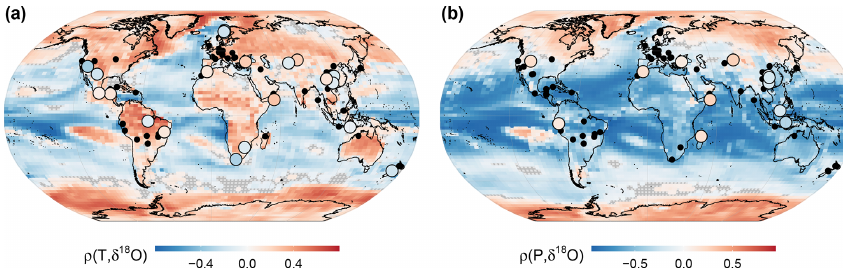
Figure 7. Correlation fields of simulated δ 18 O pw and the related climate variables surface temperature (a) and precipitation (b) for simulation LM1 ( | c | > 0 . 2 ,p < 0 . 1). Colored symbols give the correlation between simulated climate variables and the δ 18 O dw . eq of the speleothem records. Empty tiles mask non-significant correlations. Black dots show cave locations with non-significant correlations.